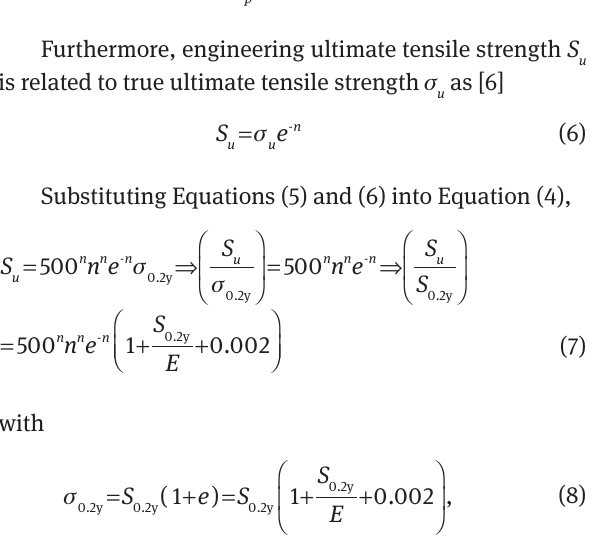
Figure 1 Engineering stress – strain curves for aeroengine isotropic materials from MMPDS data [1].